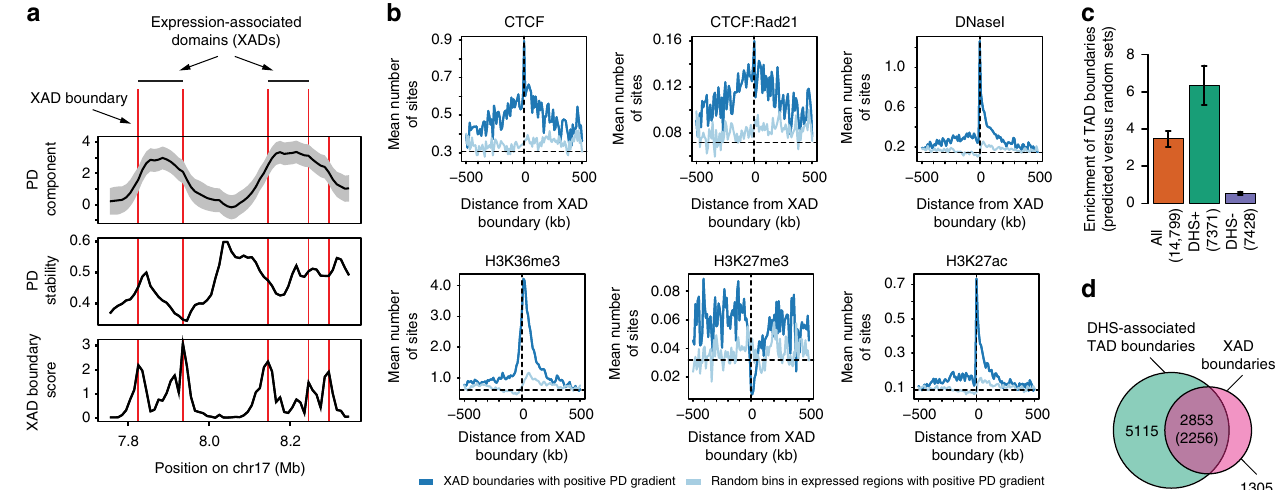
Fig. 4 Expression-associated domains mark regions of active topological domains. a Approach for identifying boundaries of expression-associated domains (XADs) based on a PD boundary score. PD signal (mean ± standard deviations), PD stability (across cell PD standard deviation) and the XAD boundary score are shown. b Average GM12878 pro fi les of binarised ChIP-seq data for CTCF, CTCF in combination with Rad21 (cohesin), DNaseI, H3K36me3, H3K27me3 and H3K27ac at XAD boundaries with positive PD gradient (dark blue) and at random expressed bins with postive PD gradient (light blue). The vertical dotted line represents boundary locations and the horizontal dotted line represents background mean for a given mark. c Enrichment of GM12878 TAD boundaries among XAD boundaries compared to random bins proximal to expressed bins (DHS+ for DHS associated, DHS − for DHS non-associated). Error bars were derived from generating the random bin set 100 times and calculating the standard deviation of their enrichment versus the actual boundaries. d Venn diagram of association between GM12878 XAD boundaries and proximal (within fi ve bins) DHS-associated TAD